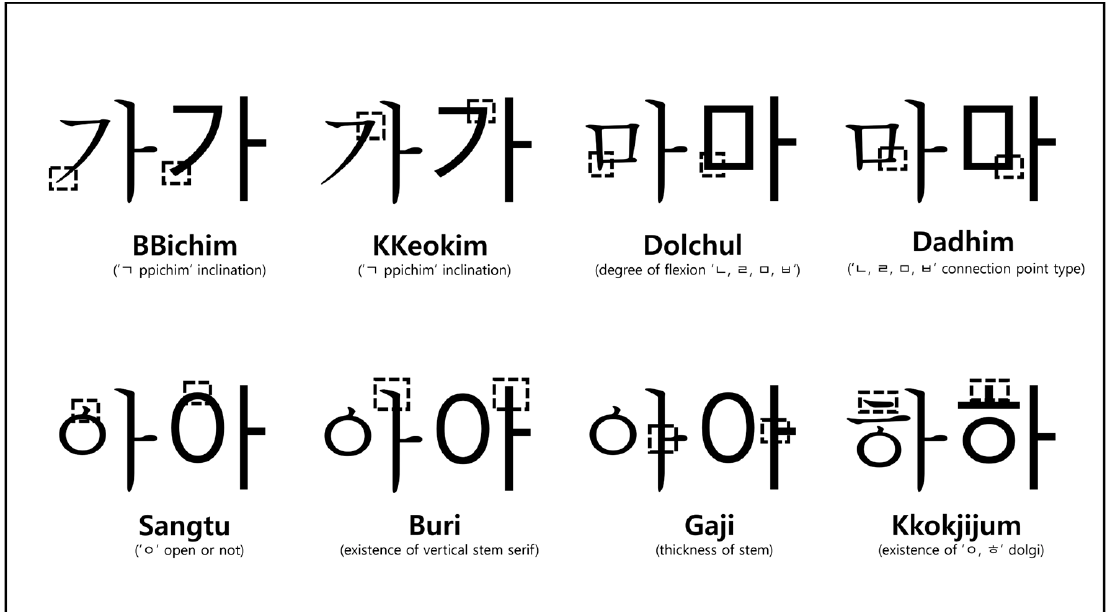
Figure 1. Eight representative stroke elements [7].